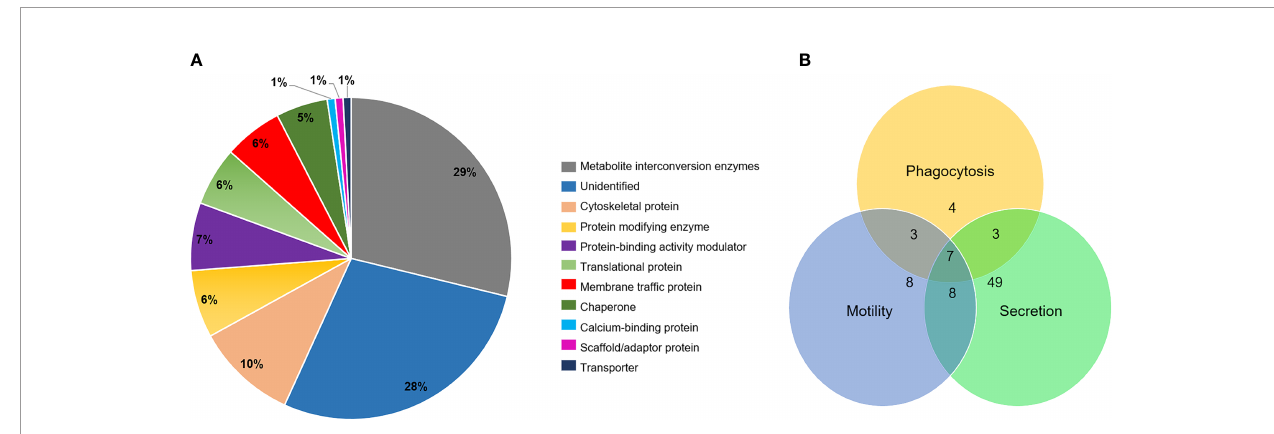
FIGURE 7 | Graphical distribution of the proteins found in the immunoprecipitation of EhVps23 from total extracts of trophozoites by mass spectrometry. (A) Proteins class analysis of the immunoprecipitation of EhVps23 proteome showing predicted molecular functions. The chart was created using PANTHER GO analysis. (B) Analysis of the proteins involved in phagocytosis, motility and secretion.